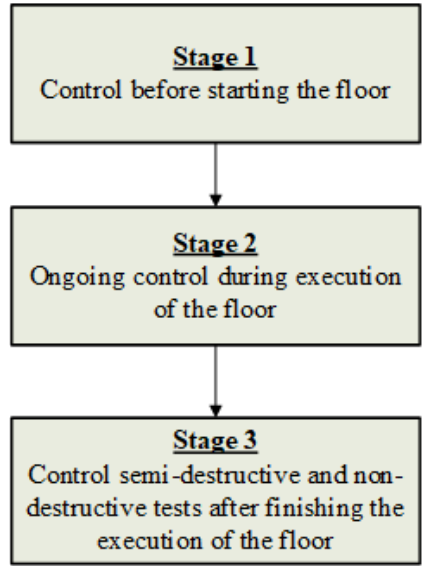
Figure 2. General diagram illustrating the developed methodology.